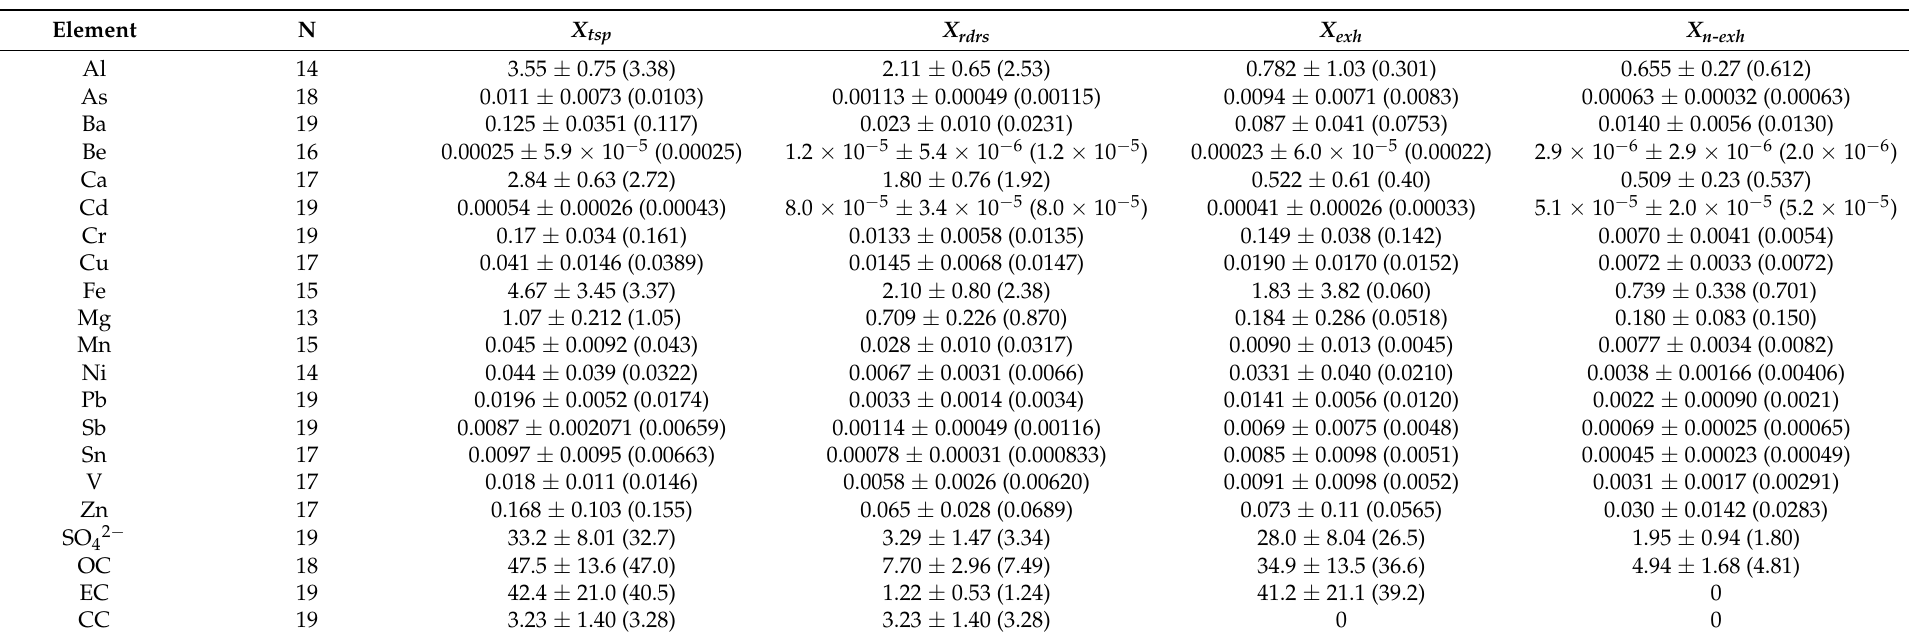
Table 1. Source apportionment results obtained from EFECT ( µ g/m 3